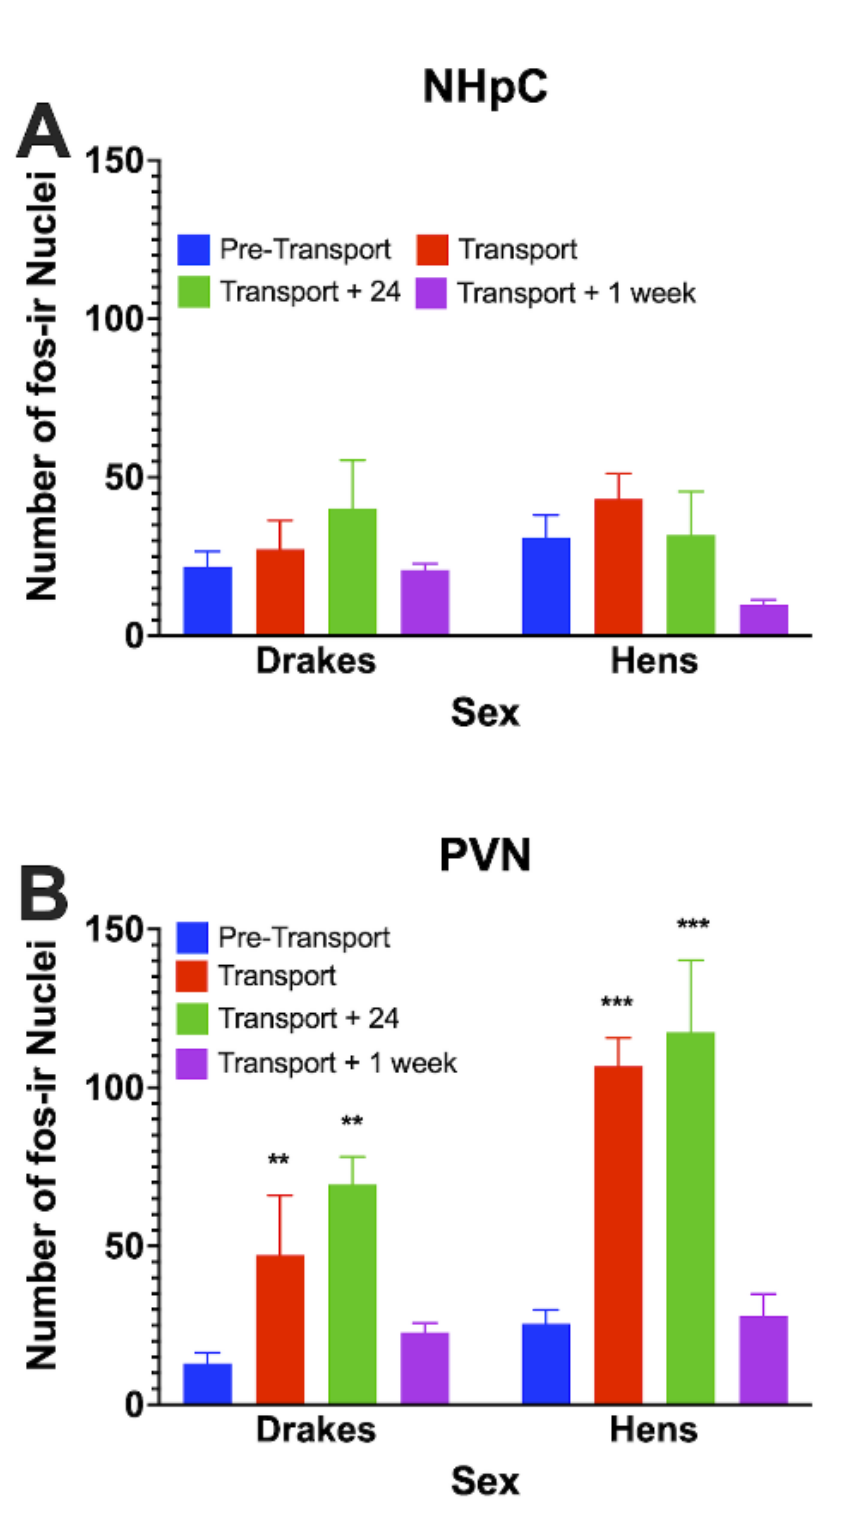
Figure 2. Fos-ir in the NHpC and PVN associated with transportation. A significant increase in the number of fos-ir was observed at Transportation in the PVN ( B ) but not in the NHpC ( A ) that lasted through the Transportation + 24 h sample time. Further, a significant sex difference was observed in that hens showed a greater number of fos-ir in the PVN compared to drakes at Transportation and Transportation + 24 h. Asterisks indicate differences from controls of the same sex where, ** = p < 0.01, *** = p < 0.001. Differences between sexes at same time points, p = 0.0036. Figure 3. Representative photomicrographs of fos-ir. Top row: no differences in fos-ir were observed in the NHpC at any time point assessed. Bottom row: the number of fos-ir nuclei in the PVN in- creased with Transportation and continued to show increased numbers for 24 h before returning to Pre-transport levels. Arrows = fos-ir nuclei. AC = anterior commissure. 3v = third ventricle. Bar = 100 um. Arrows point to representative fos-ir.